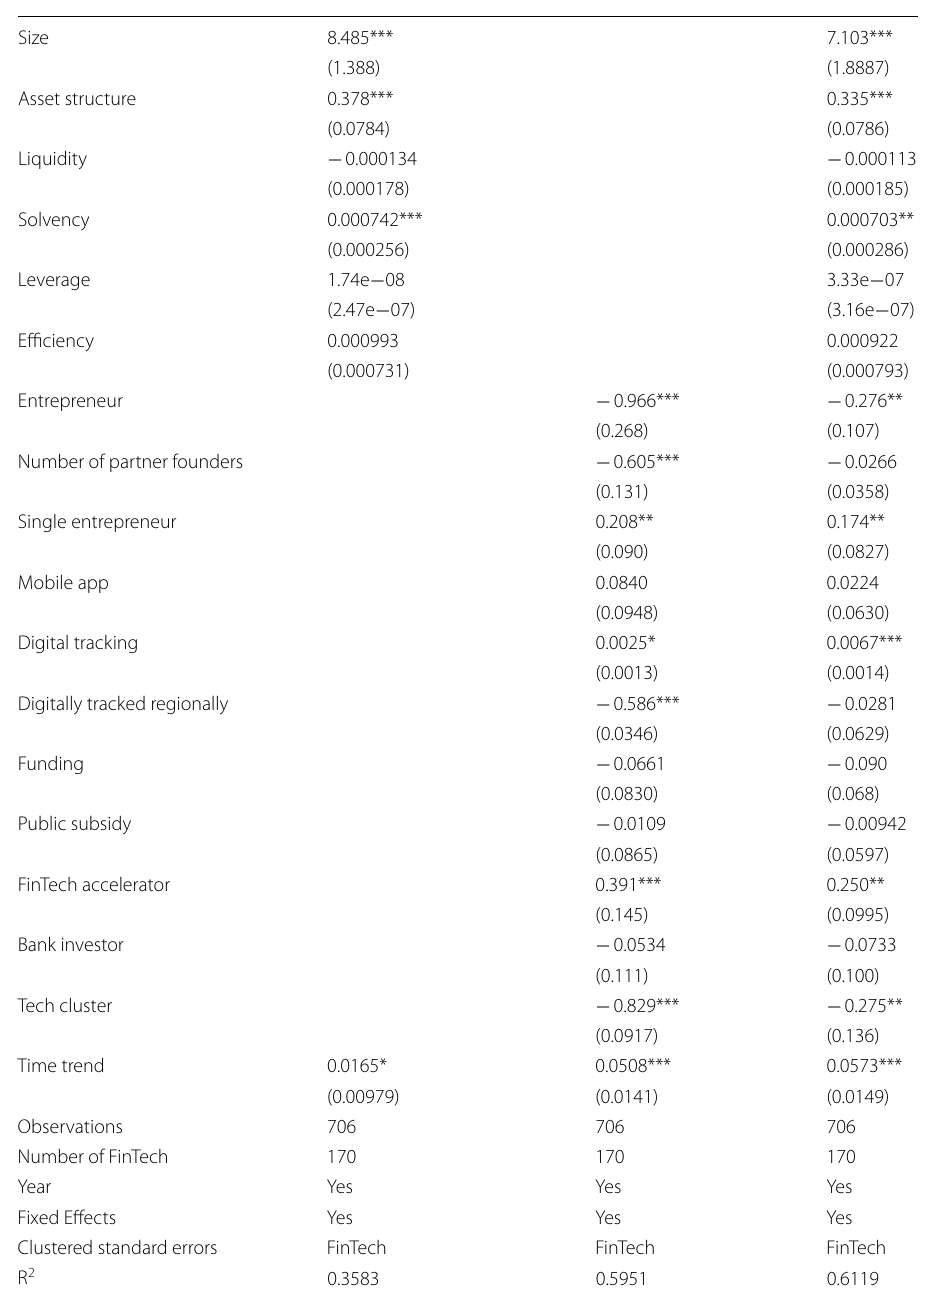
Table 7 Drivers of being a profitable FinTech